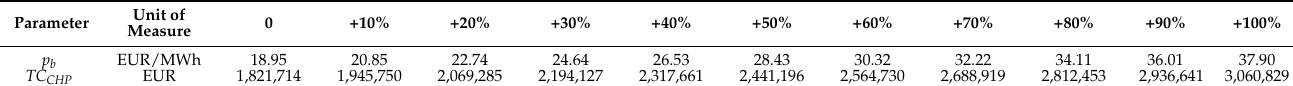
Table 4. Sensitivity of total costs to the fuel price changes.